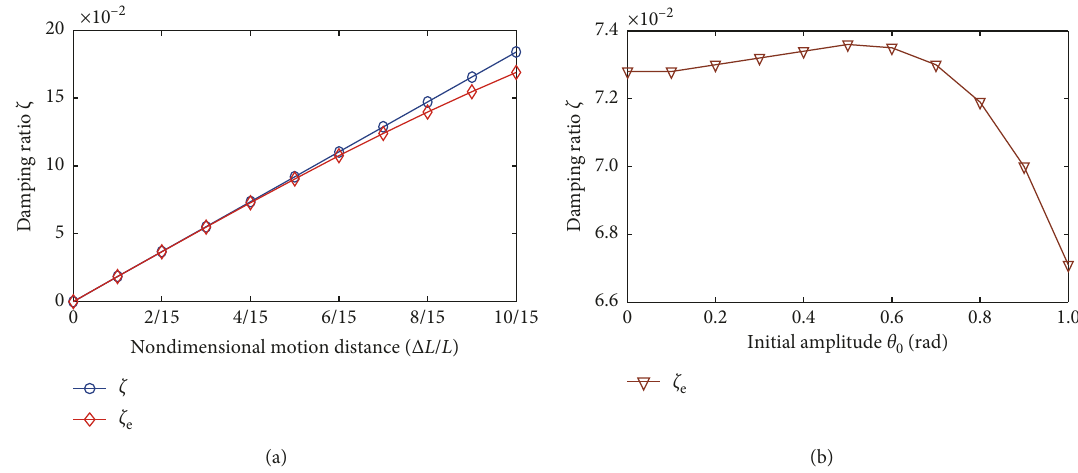
∆ L on the equivalent damping ratio ζ and the exact